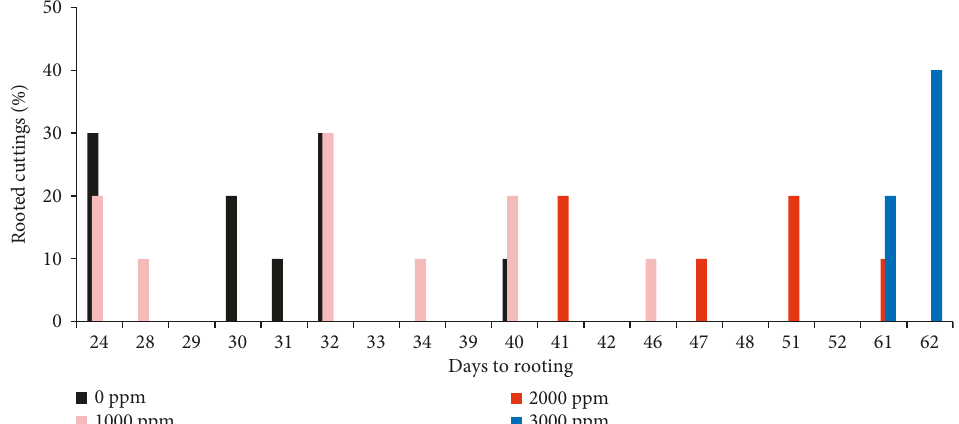
Figure 4: Rooting time of T. cacao cuttings treated with different concentrations of